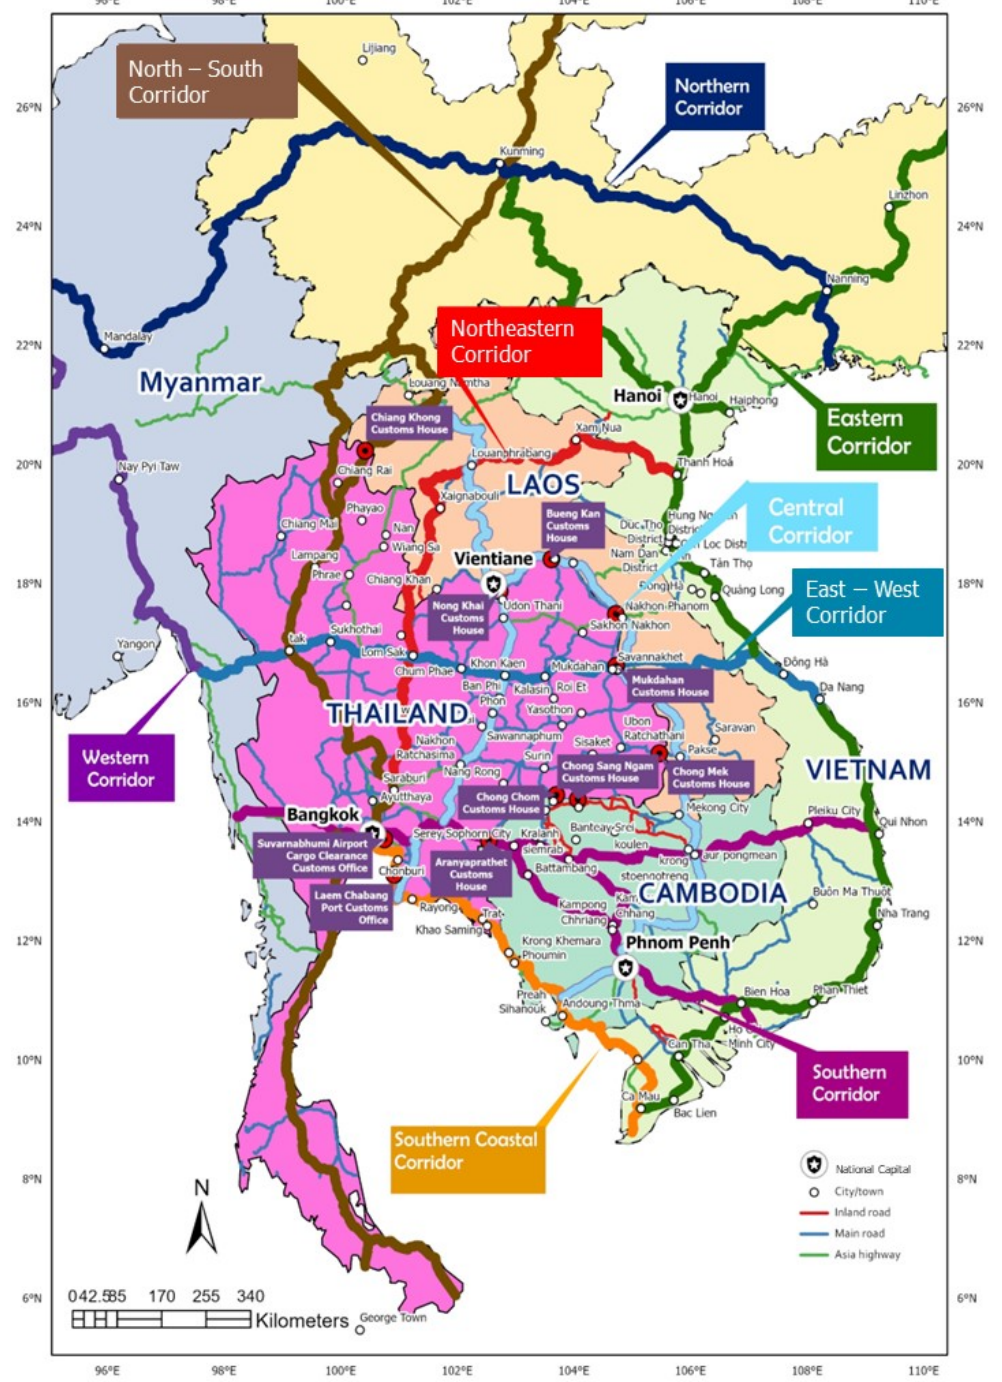
Figure 1. Overview of logistics in the Greater Mekong Subregion corridors [7] (Sources: ESRI, HERE, Garmin, FAO, NOAA, USGS, OpenStreetMap contributors and the GIS user community).